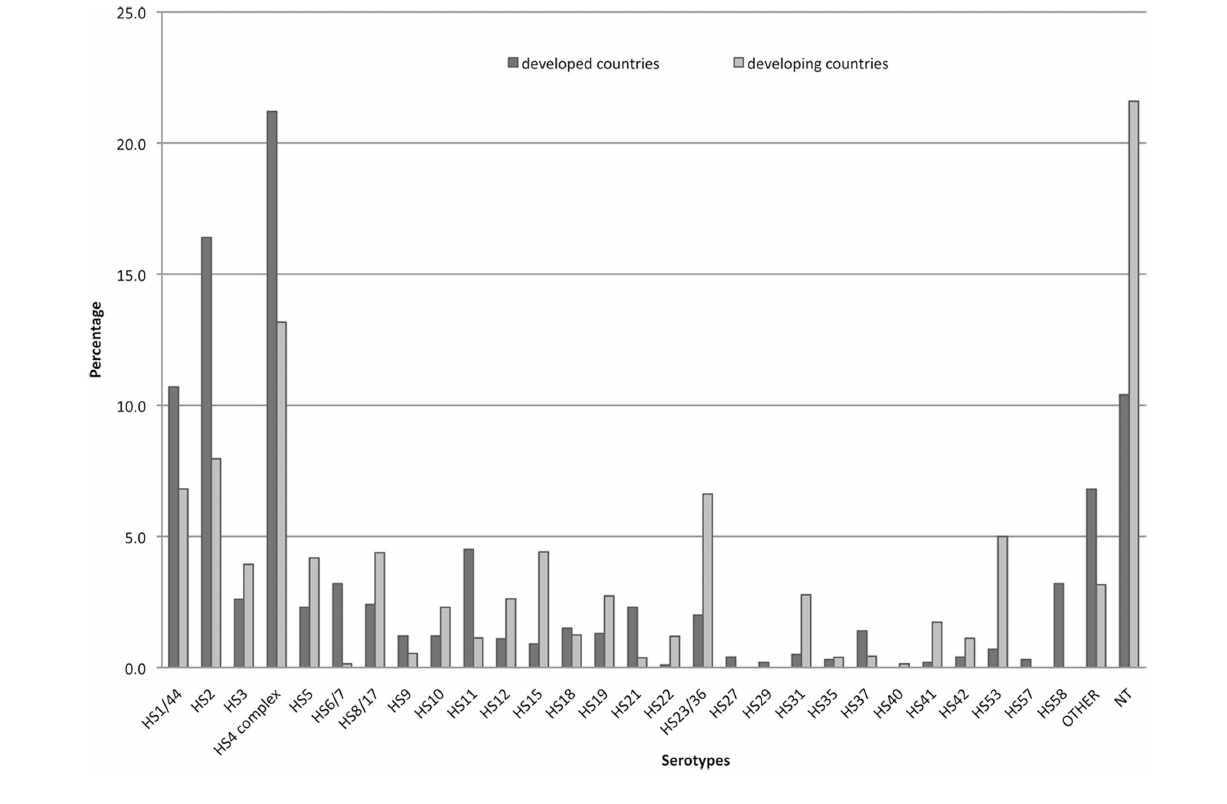
FIGURE 4 | Penner serotype distribution worldwide. The data represent a total of > 16,000 strains from developed countries (Penner and